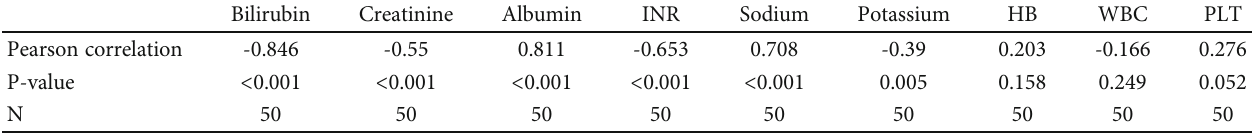
The table is showing a strong negative correlation in the HE group, between bilirubin level, creatinine, INR, and potassium and serum 25-OHD. A strong positive correlation was detected between albumin level and sodium level and serum 25-OHD level. No correlation was found between 25-OHD level and hemoglobin level, WBCs, or platelet count. Pearson ’ s correlation test was used. Table 13: Multiple logistic regression for the serum 25-OHD and serum Albumin levels in association with HE.